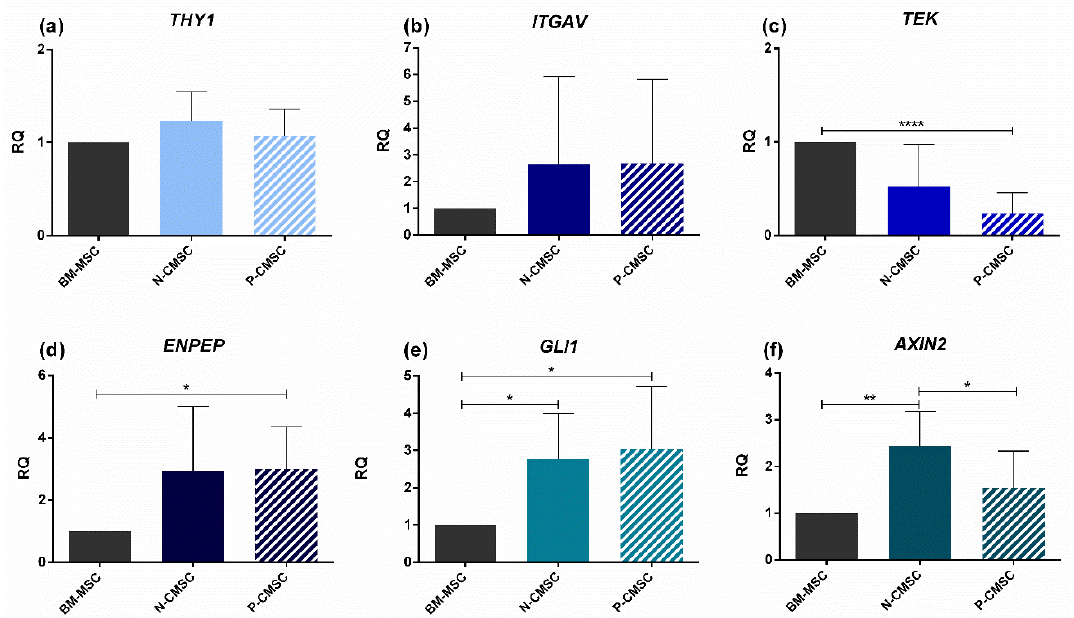
Figure 4. Comparative expression profiling of marker genes in iliac crest BM-MSC and suture cells CMSC. Transcript levels of: ( a ) THY1 ; ( b ) ITGAV ; ( c ) TEK ; ( d ) ENPEP ; ( e ) GLI1 ; and ( f ) AXIN2 , evaluated by qPCR in N- and P-CMSC, compared with BM-MSC. RQ, Relative Quantity (see Methods for details). * p < 0.05; ** p < 0.01; **** p < 0.0001.